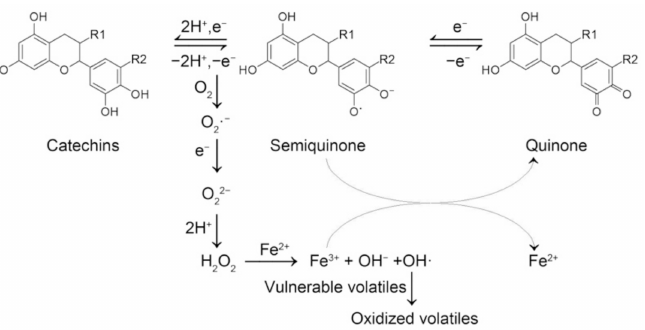
Figure 6. Proposed reaction scheme for the effect of ferrous ion on heat-induced aroma deterioration of green tea